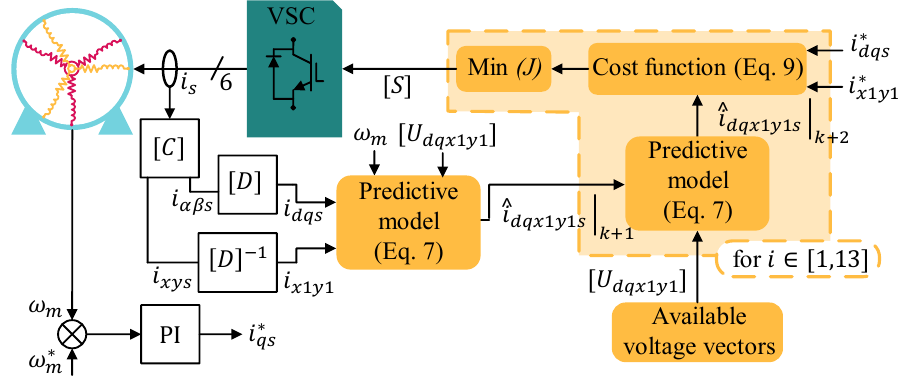
Figure 6. Standard LFCS-MPC control